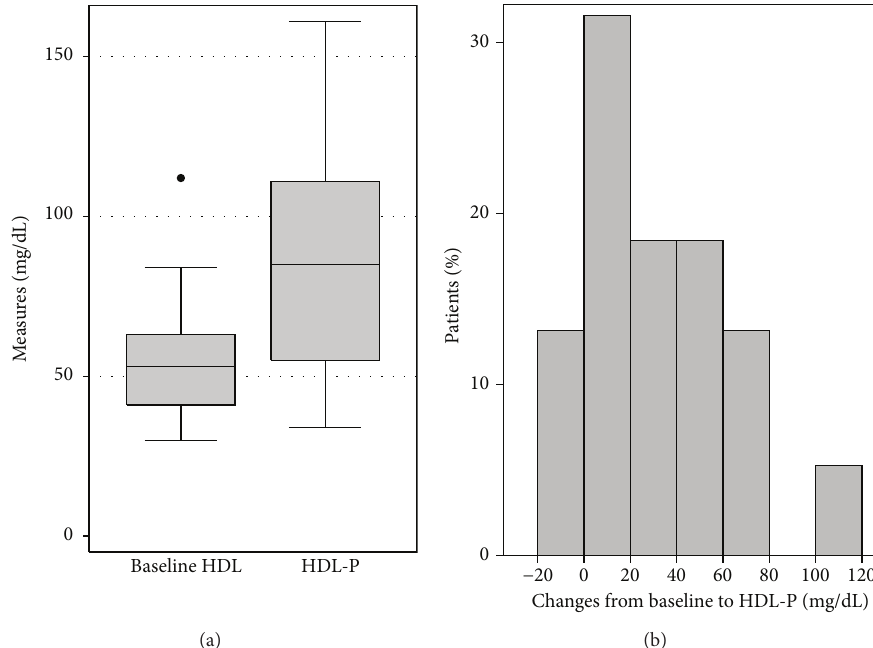
Figure 1: (a) Box plot illustrating HDL-c level at baseline (baseline HDL) and the peak HDL-c during mitotane therapy (HDL-P). Mean baseline HDL was 53.3 mg/dL and mean HDL-P was 86.3 mg/dL ( 𝑃 < 0.001 ). (b) A histogram showing the distribution of within-patient HDL-c changes.